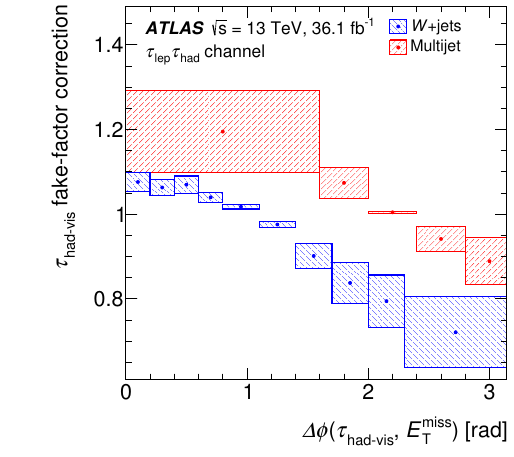
(cid:1) (cid:30) ( p (cid:28) had-vis ; E miss ) correction T T j j